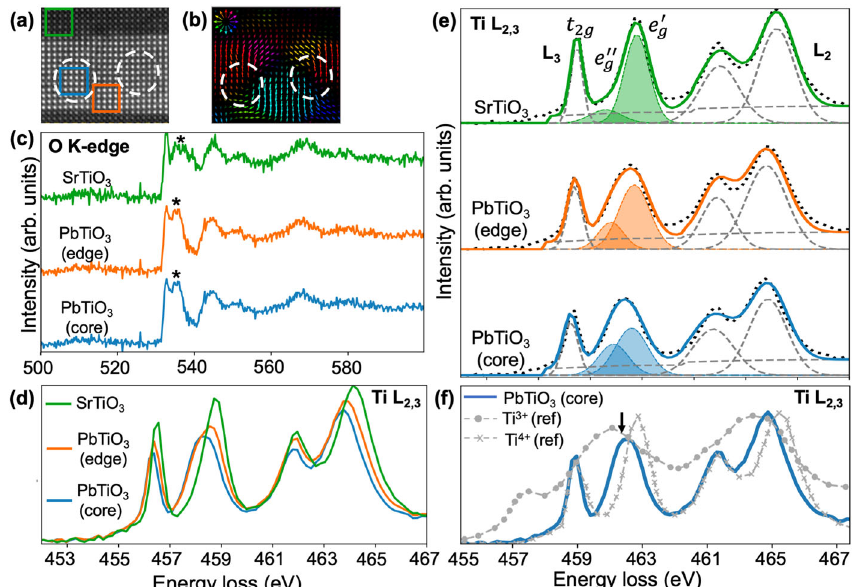
Fig. 2 EELS of the polar vortices. a Simultaneously acquired HAADF-STEM image. b The corresponding A site displacement vector map with white circles indicating the position of the vortex cores. c De-noised O K edge, and d Ti L edge spectra of STO, PTO at the vortex core, and edge summed from the green, blue, and orange boxes (respectively) overlaid on a . Each box contains 15 × 15 scan positions. e Gaussian fi ts of the Ti L edge EEL spectra with Hartree-Slater background. f PTO vortex core spectrum in comparison to Ti 3 + and Ti 4 + reference spectra. The absence of any extra broadening in the t 2g as compared to the standard Ti 4 + spectrum negates the possibility of Ti 3 + in the